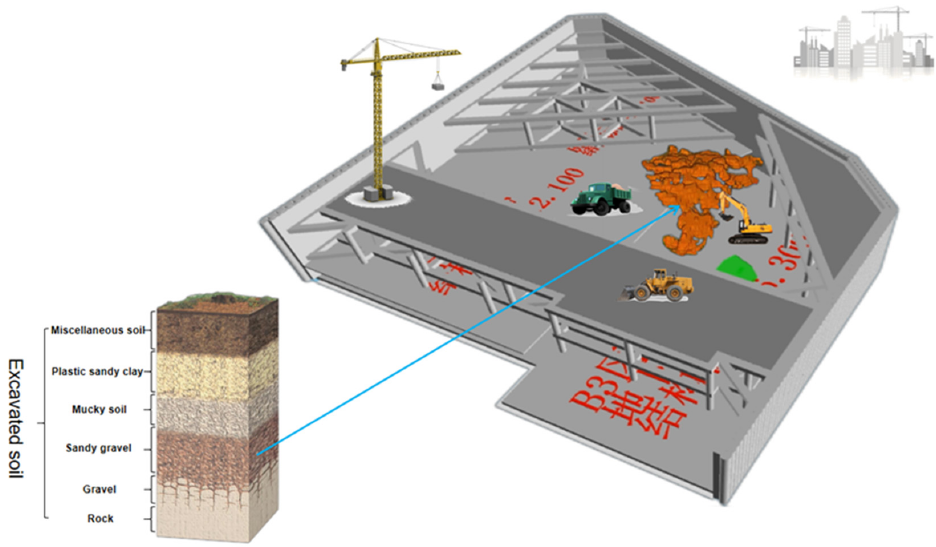
Figure 6. The simulation of excavated soil recycling process.